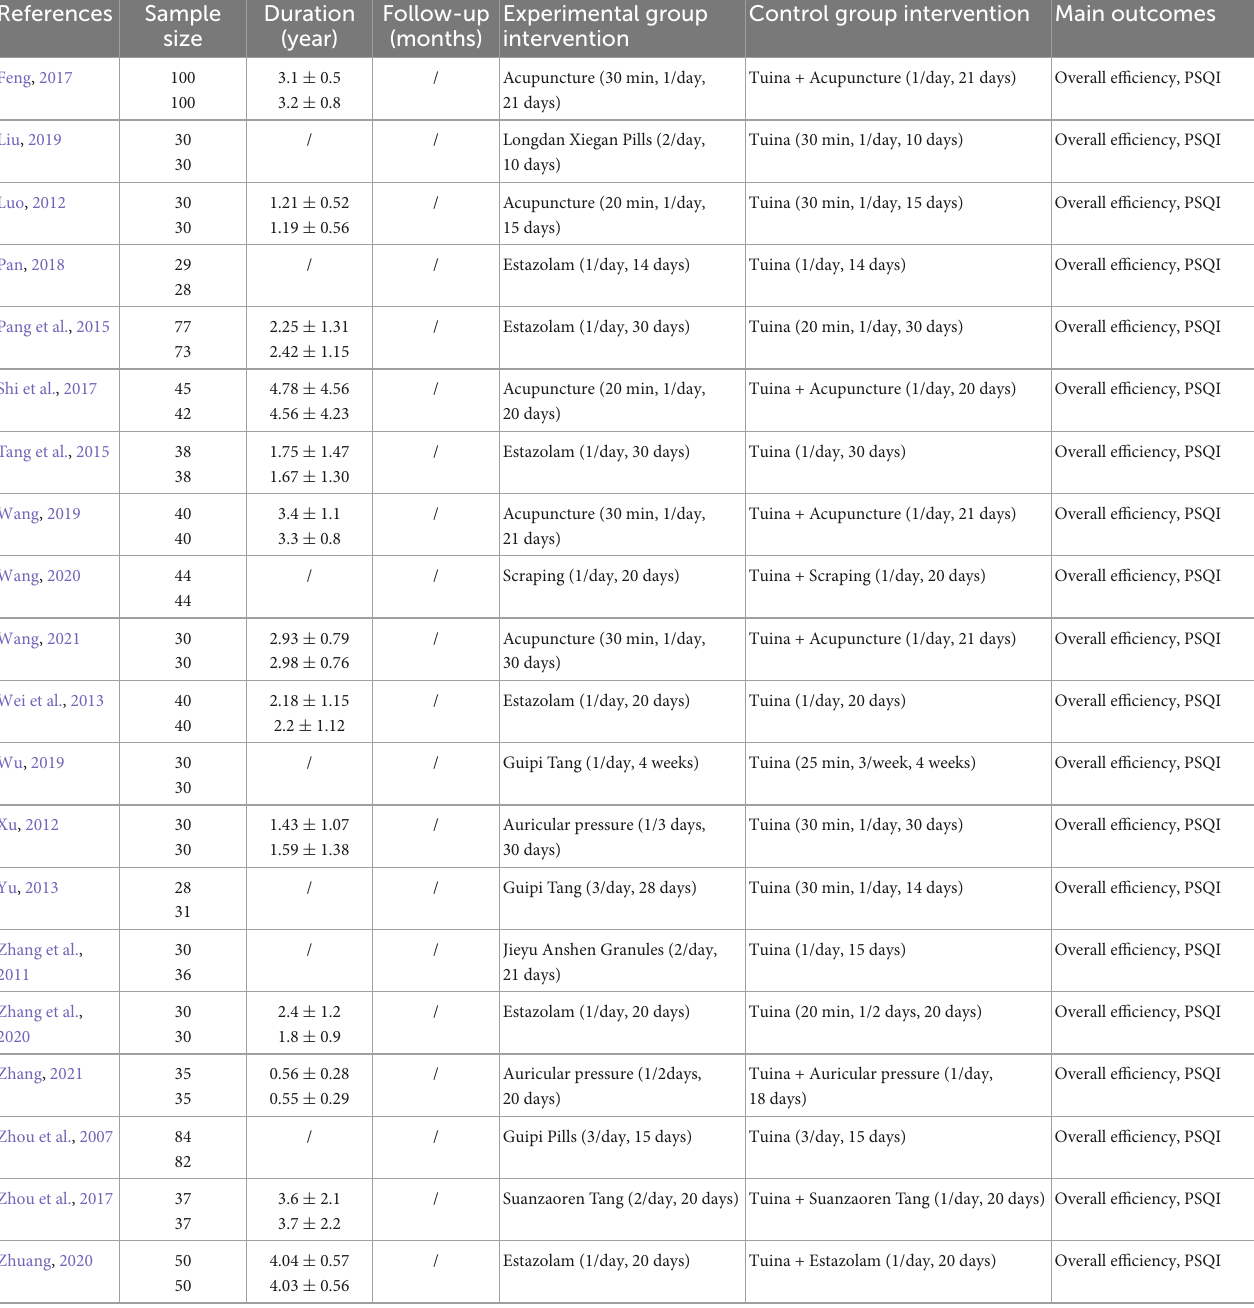
TABLE 1 Randomized controlled trials evaluating the effects of tuina for